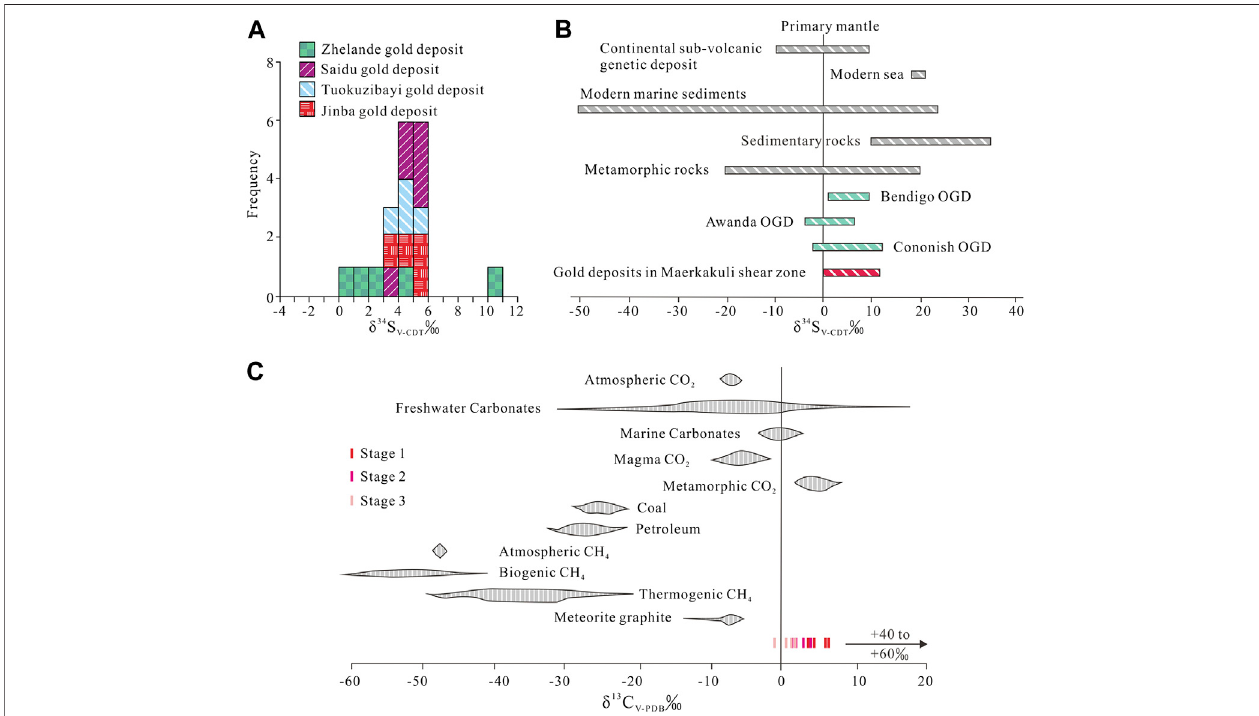
FIGURE 7 | (A ) Histogram showing δ 34 S values of pyrites from gold deposits in Maerkakuli Shear Zone (data from Xu et al., 2009; Deng, 2011; Zhan et al., 2016; Gao, 2020). (B) δ 34 S values from pyrites of gold deposits in Maerkakuli Shear Zone compared to the values in important geological reservoirs (data from Ohmoto and Goldhaber, 1997; Bierlein et al., 2004; Ding et al., 2014; Spence-Jones et al., 2018). (C) δ 13 C values from quartz of the Jinba gold deposit compared to the values in important geological reservoirs (data from Clark and Fritz, 1997).